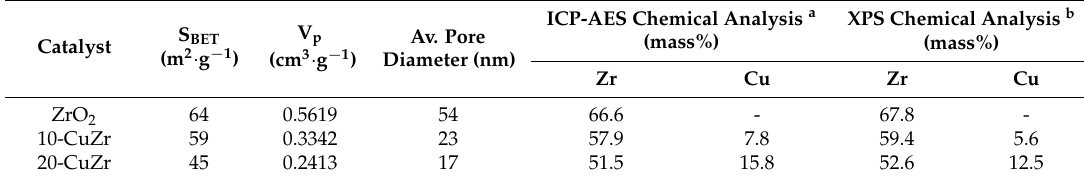
Table 2. Results from N 2 ‐ physisorption, ICP ‐ AES and XPS analysis of the samples.